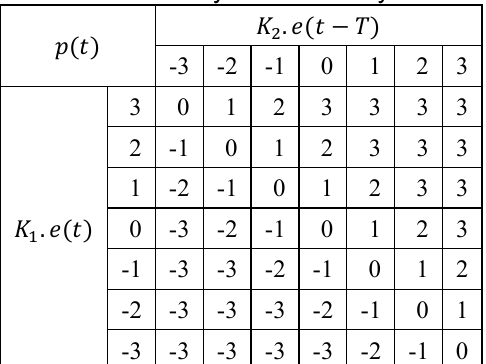
Table 3. Index systems of fuzzy rules